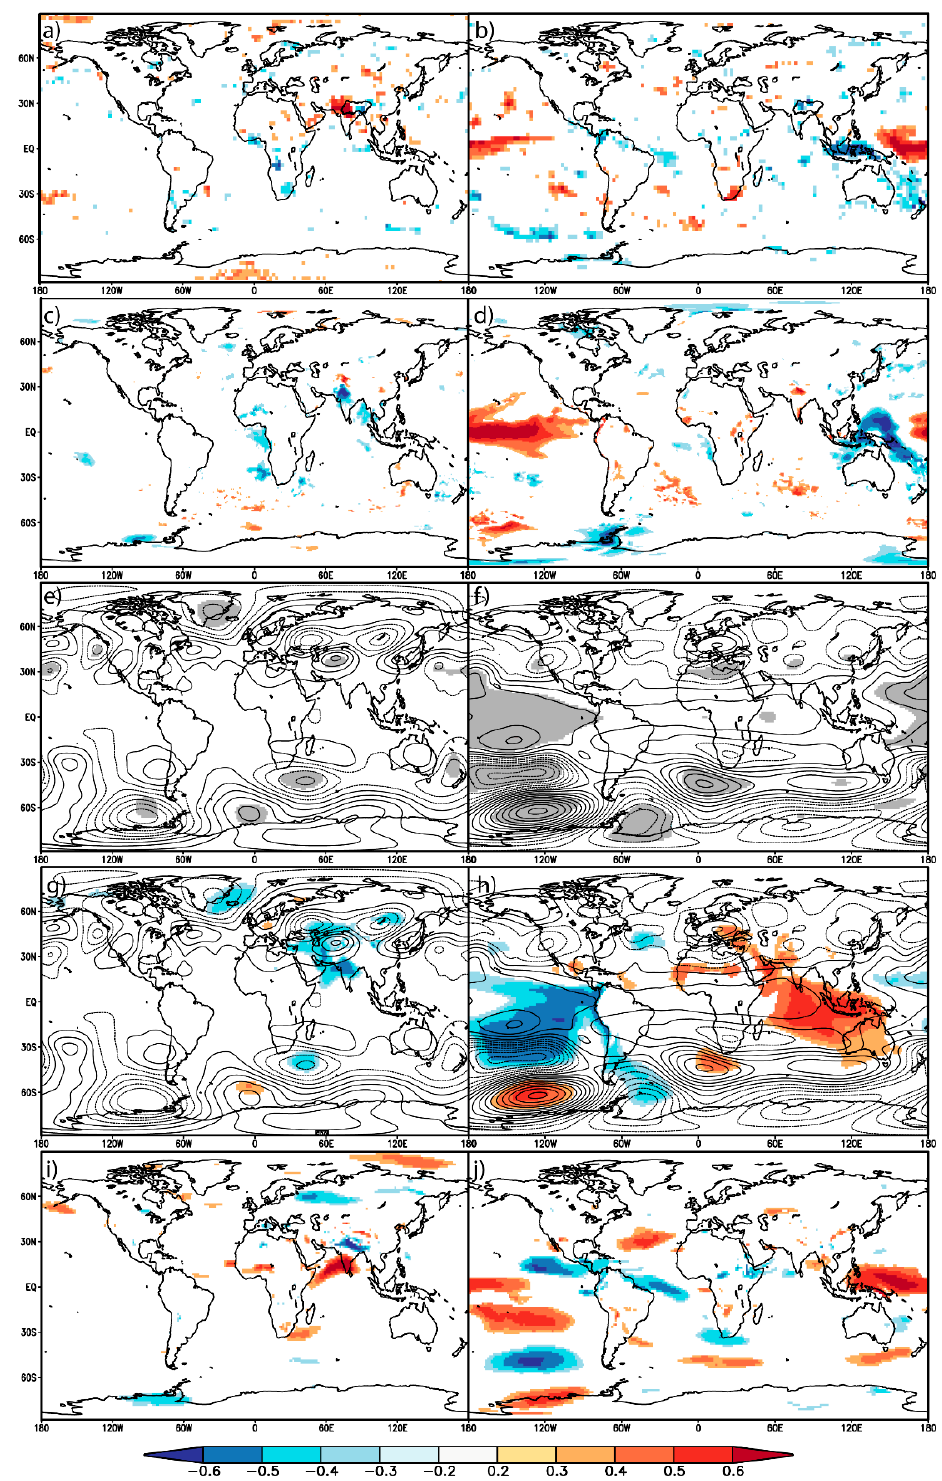
Figure 3. Correlations significant at the 95th percentile between eigenvector coefficients (see Figure 1) and June-July-August-September averaged global atmospheric fields from 1983 to 2015. See color bar for scale. Contours in ( e – h ) are regressions of the coefficients with 200 hPa heights. The solid (dashed) lines represent positive (negative) values and shading is significance at the 95th percentile. Increments are 200 m. The GBM boundary is outlined in ( a ) and ( b ). ( a ) precipitation and PC2; ( b ) same as ( a ), but PC3; ( c ) 2-meter air temperature and PC2; ( d ) same as ( c ), but PC3; ( e ) 200 hPa heights and PC2; ( f ) same as ( e ) but PC3; ( g ) 850 hPa heights and PC2; ( h ) same as ( g ) but PC3; ( i ) 850 hPa zonal wind stress and PC2; ( j ) same as ( i ) but